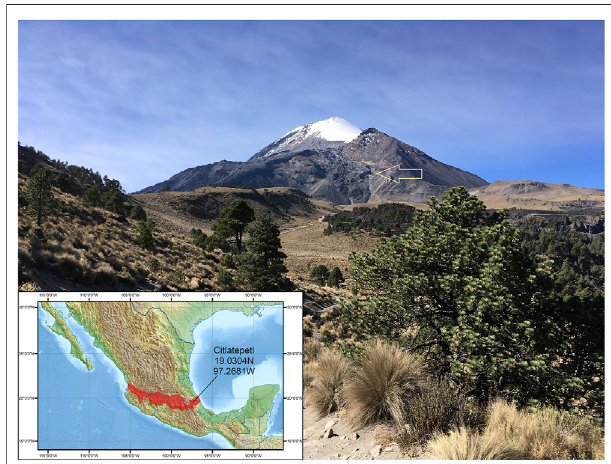
FIGURE 1 | Photo of Citlaltépetl, view of the north face. The Jamapa glacial valley and recent lava fl ow can be seen in the lower mid-section of the volcano. Arrow shows lahar inception area in the uppermost Jamapa watershed. Inset map shows location of the mountain, at the east end of the Trans-Mexican Volcanic Belt (shaded